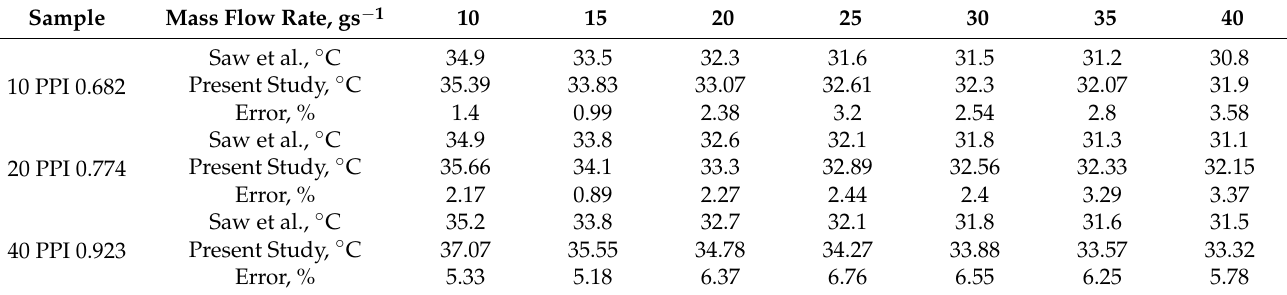
Table 6. Comparison of battery temperature with AFHS